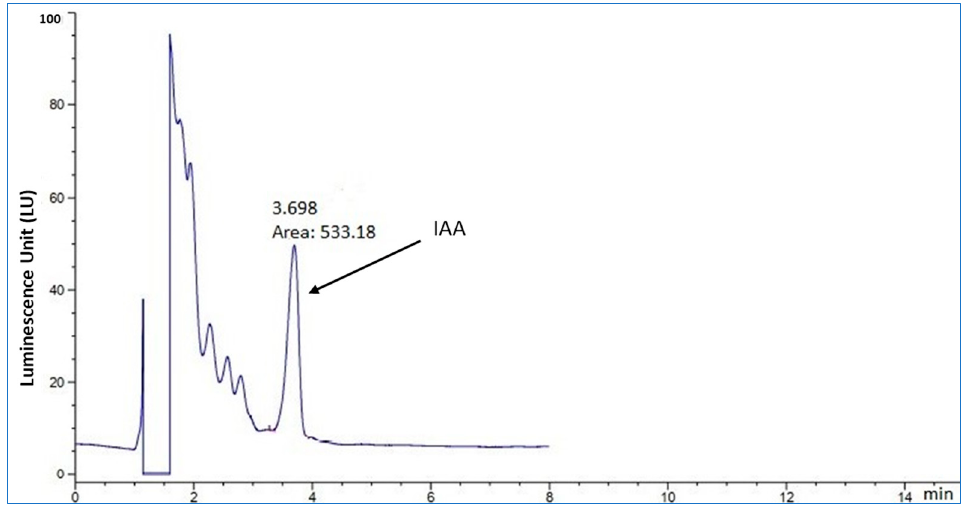
Figure 4. IAA detection by HPLC in the culture broth of P12 isolate grown for three days.